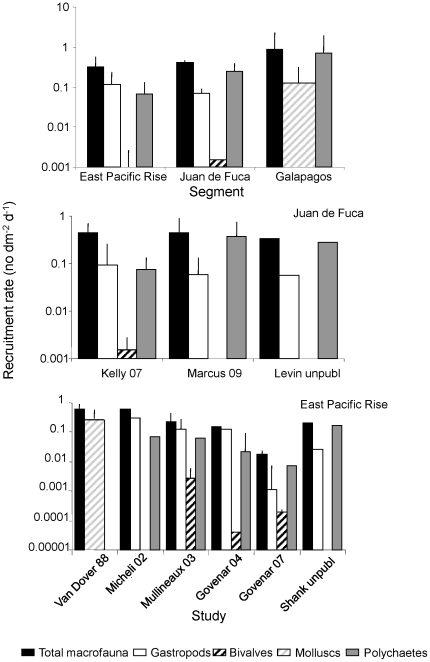
Rate of recruitment (+SD) of three invertebrate families and of total macrofauna at vents.Rates are estimated based on the deployment of substrates for known periods of time at the Juan de Fuca Ridge and East Pacific Rise. Top panel shows rates averaged across all studies for each segment. Middle and bottom panels show rates averaged for each study. Van Dover et al. (1988) only provided combined rates for molluscs (instead of separate rates for gastropods and bivalves; wider bar denotes this) for both Galapagos Rift (top panel) and East Pacific Rise (bottom panel).